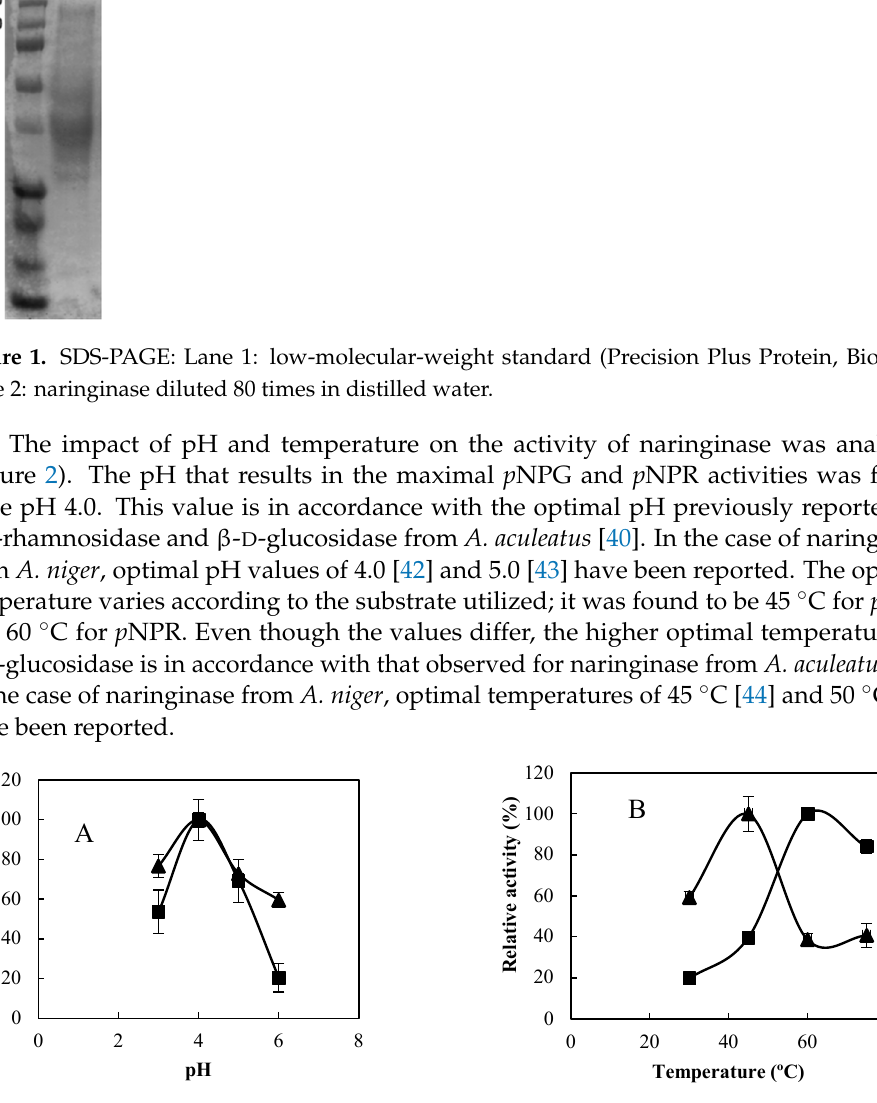
Figure 2. Effect of ( A ) pH and ( B ) temperature on the relative activity of free naringinase using, as substrate, ∎ p -nitrophenyl-β-D-Glucoside ( p NPG) and ⯅ p -nitrophenyl-α- L -rhamnopyranoside ( p NPR).